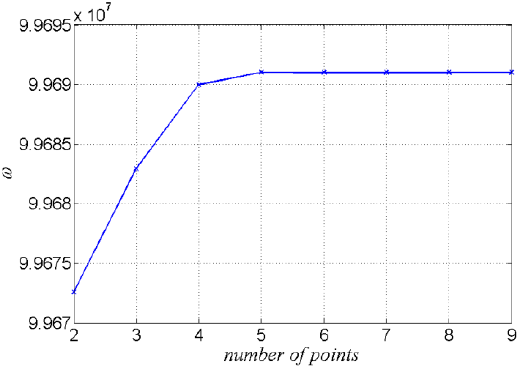
Figure 2. The number of the chosen points and the frequencies calculated.